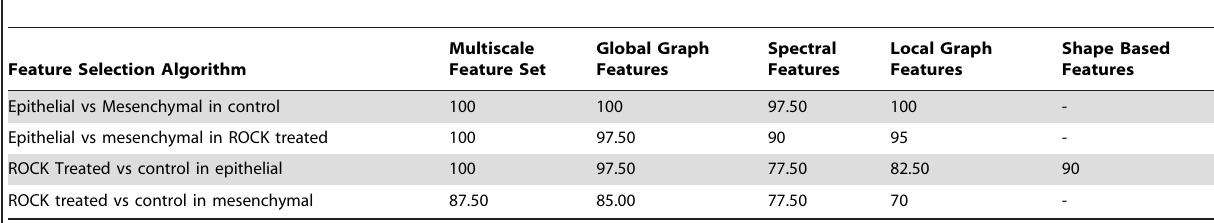
Table 9. Comparison of the learning accuracies using all the multi-scale features or only global graph features, spectral features, local graph features or morphological